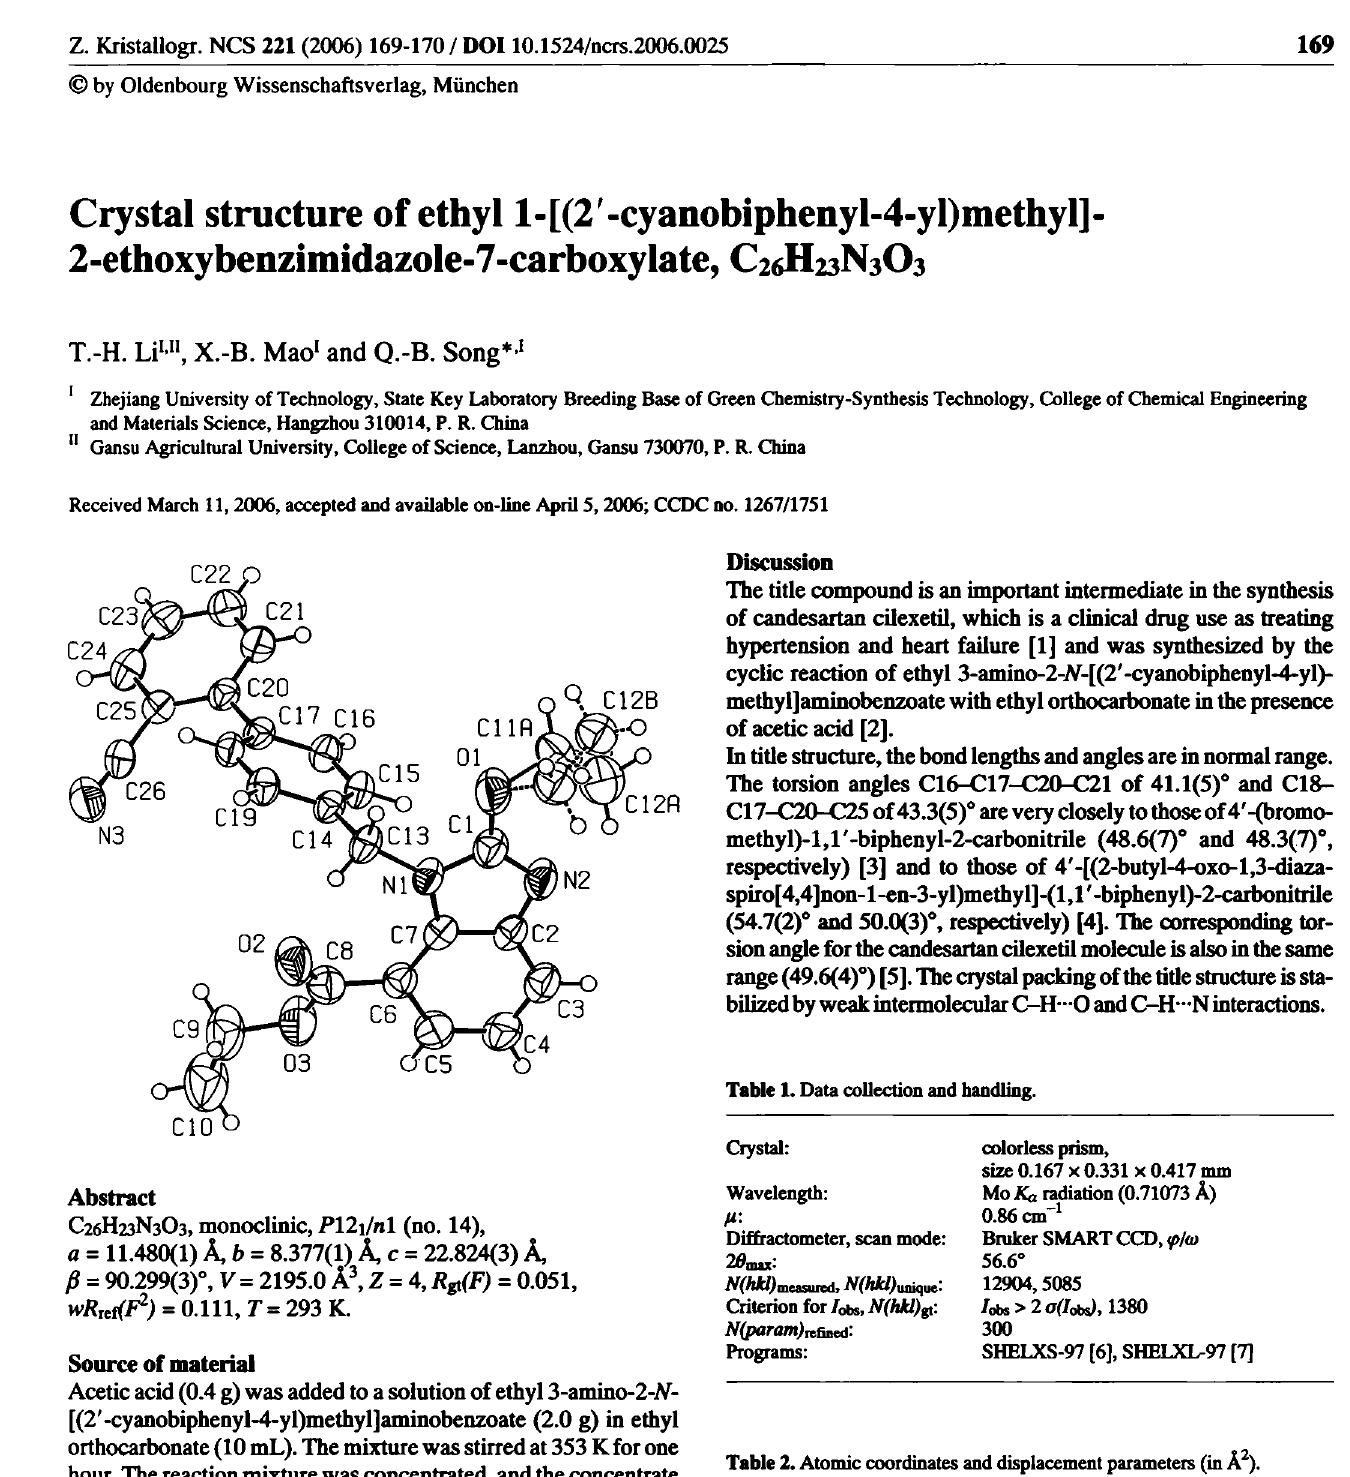
Table 2. Atomic coordinates and displacement parameters (in A 2